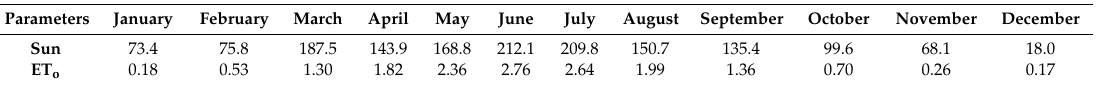
Table 1. Observed sunshine hours (per month) and the respective estimated reference evaporation (ET o in mm/day) for Köln ‐ Bonn.